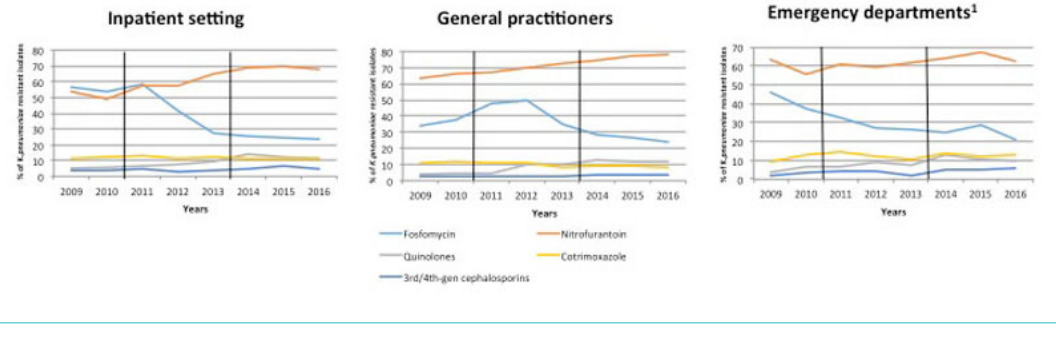
Figure 3: Proportion ofresistant P. mirabilis isolates from urine samples collected from inpatients and outpatients between 2009 and 2016 in Switzerland. Data were provided by ANRESIS, the national laboratory-based antimicrobial resistance surveillance system. Vertical black lines indicate the time period of the switch from CLSI to EUCAST breakpoints. Nitrofurantoin resistance data are not presented since P. mirabilis is considered to be intrinsically resistant. 1 Includes outpatient clinics within